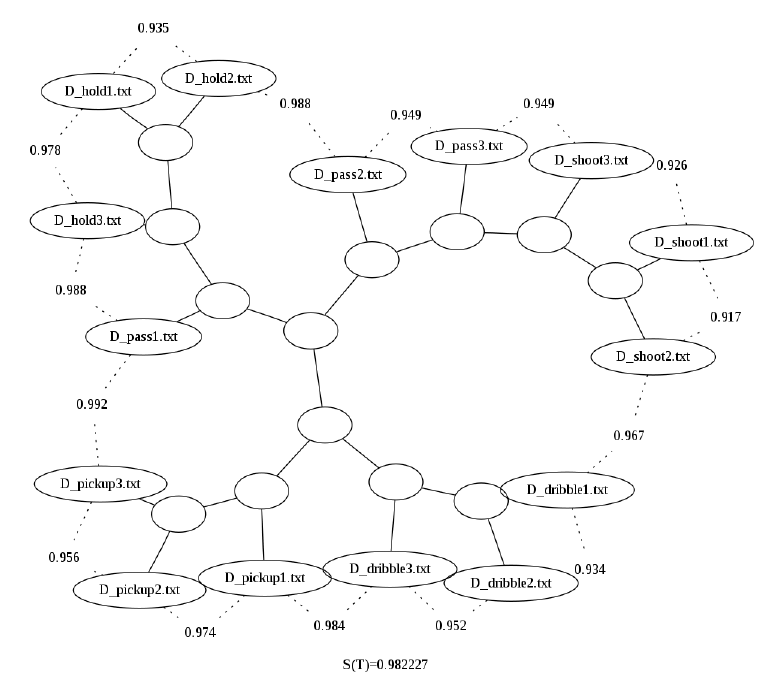
Figure 5. Binary tree generated using the looped data and bzlib with compression by column over the Basketball data set